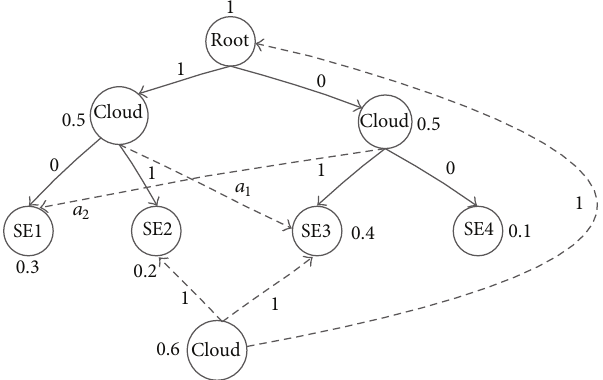
Figure 6: Cloud platform architecture for efficient data mining.